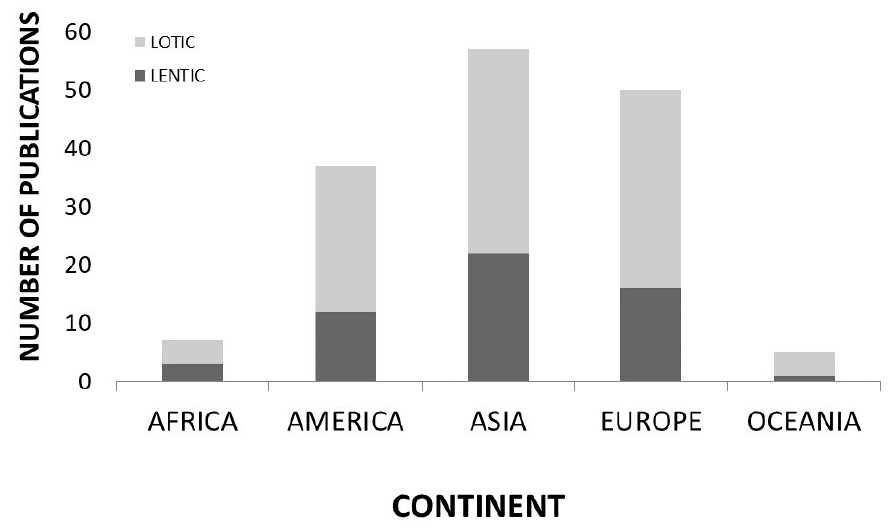
Figure 2. Number of publications on freshwater microplastics per study area.